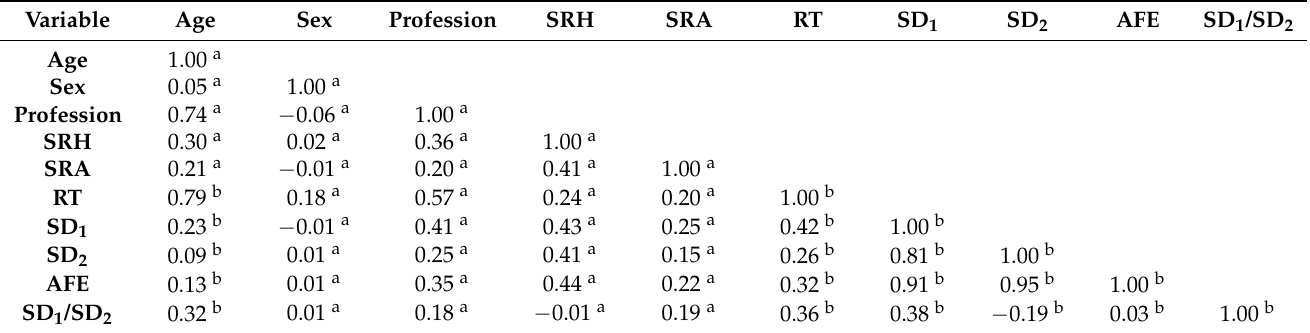
Table 4. Matrix of correlations between the recorded variables ( n = 120).